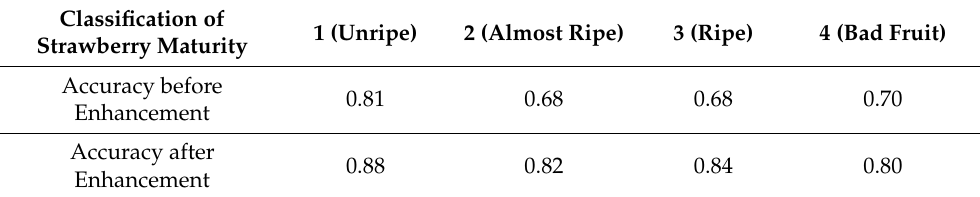
Table 7. Dark channel enhancement effect test in